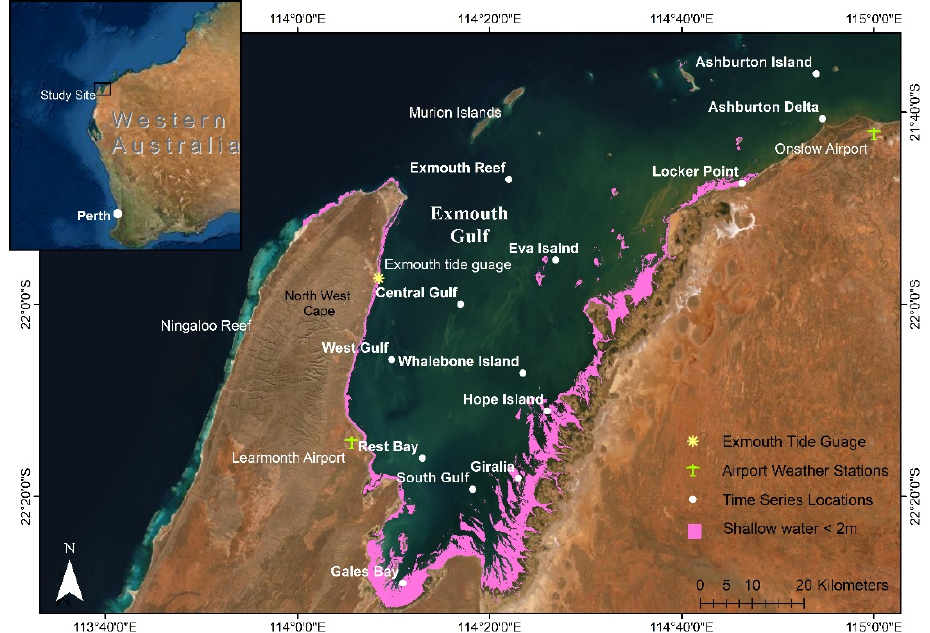
Figure 1. The study site, Exmouth Gulf, located in northern Western Australia. Symbols represent 13 locations where long-term turbidity and its metocean drivers are analysed, location of the Exmouth tide gauge and location of the airport weather stations. Pink areas denote shallow water where satellite derived bathymetry estimates depths of less than two metres during lowest astronomical tides. Note: Some sites are named for their proximity to known landmarks and may not represent the exact location of that landmark. Basemap images are from Environmental Systems Research Institute (ESRI) Online.